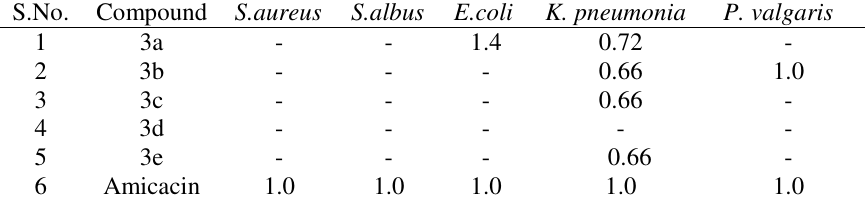
Table 2 . Antibacterial activity of synthesized compounds